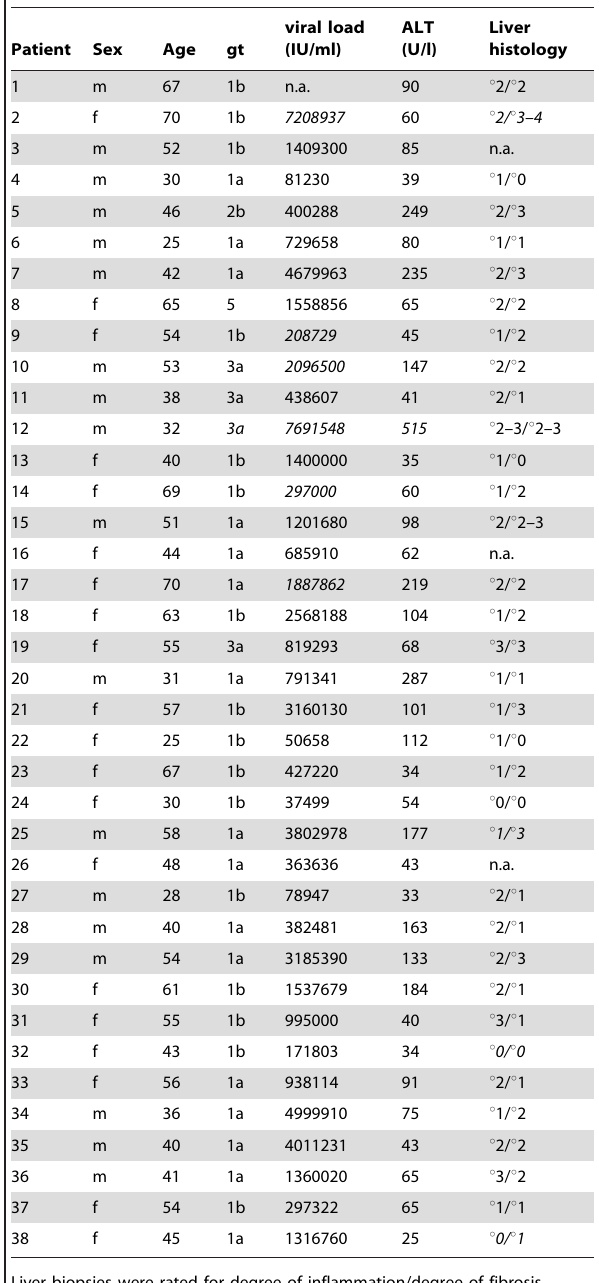
Table 1. Characteristics of the study population.